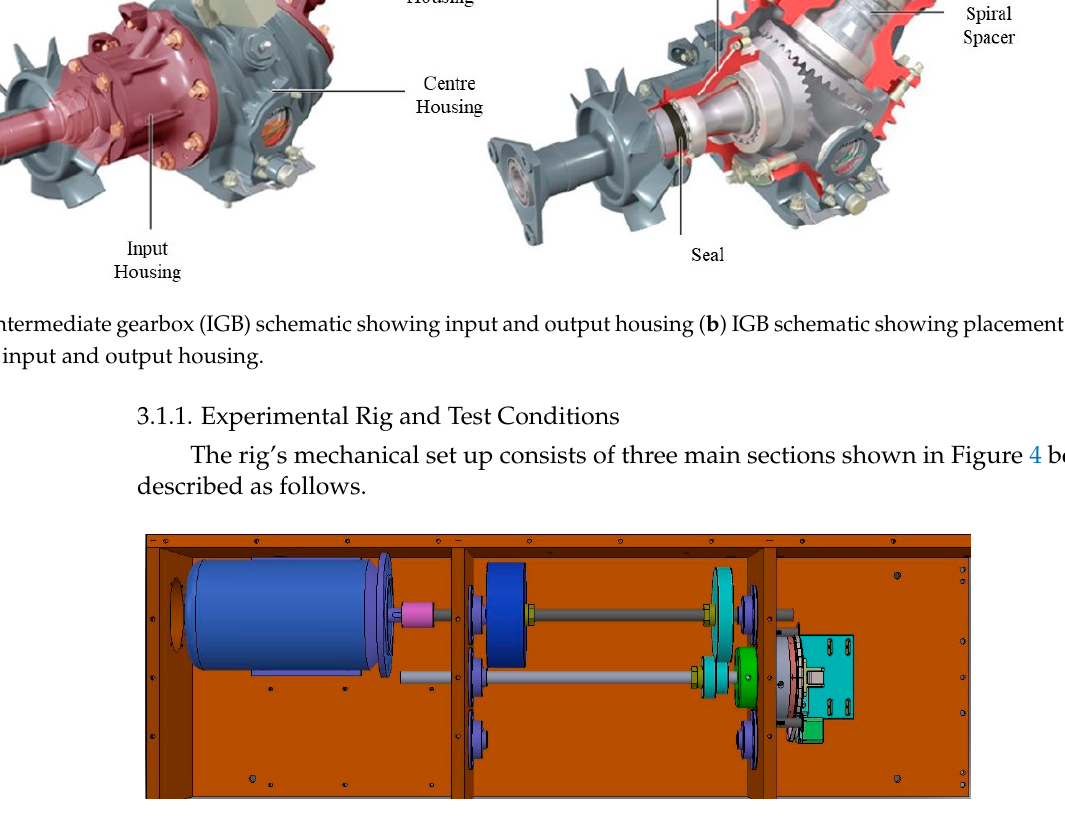
Figure 4. Top view of test rig designed displaying three sections from left to right: motor, transmissions (gears), and seal test bench.